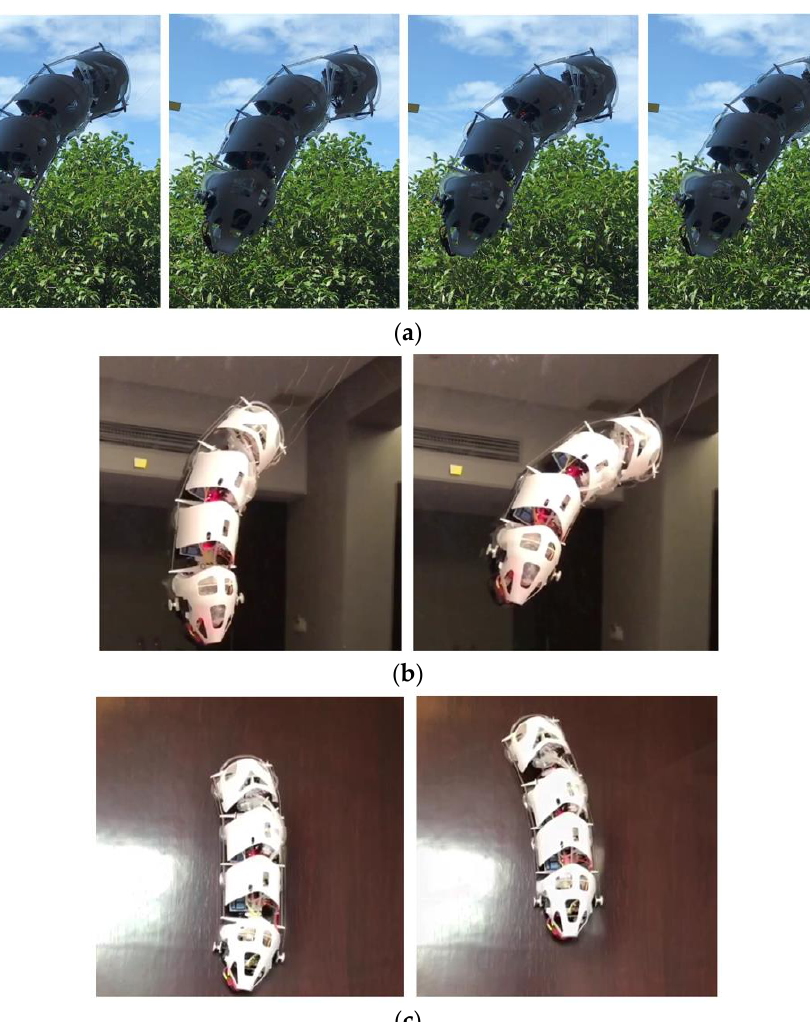
Figure 13. Performance demonstration of the robot climbing a vertical glass surface: ( a ) photos of a gait sequence on a vertical glass surface; ( b ) the locomotion of the robot in two minutes on a vertical glass surface; ( c ) the locomotion of the robot in 2 minutes on a painted wooden